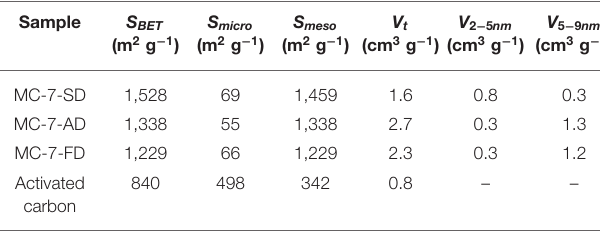
TABLE 1 | Textural properties of MC-7-SD, MC-7-AD, MC-7-FD and activated carbon. Sample